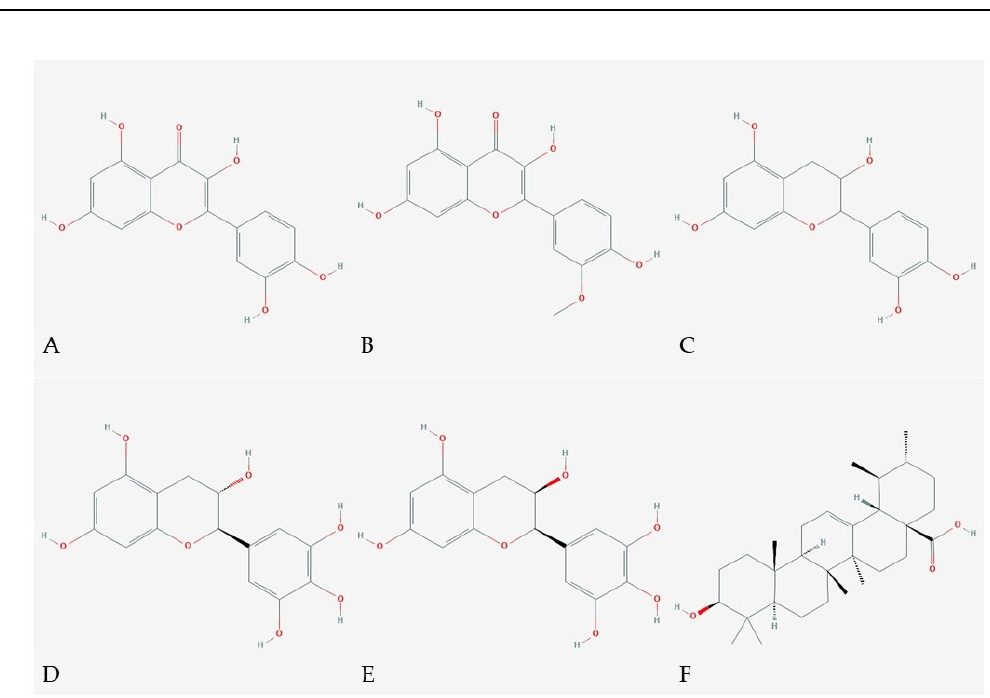
Figure 3. Structures of the most relevant phytochemicals with present in sea buckthorn with medicinal value ( A )—quercetin, ( B )—isorhamnetin, ( C )—catechin, ( D )—gallocatechin, ( E )— epigallocatechin, ( F )—ursolic acid